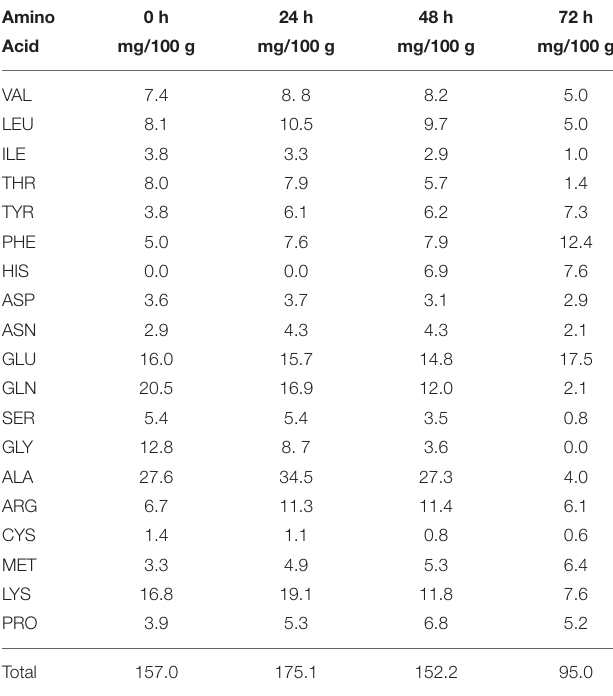
TABLE 3 | Concentration of free amino acids in a meat model over